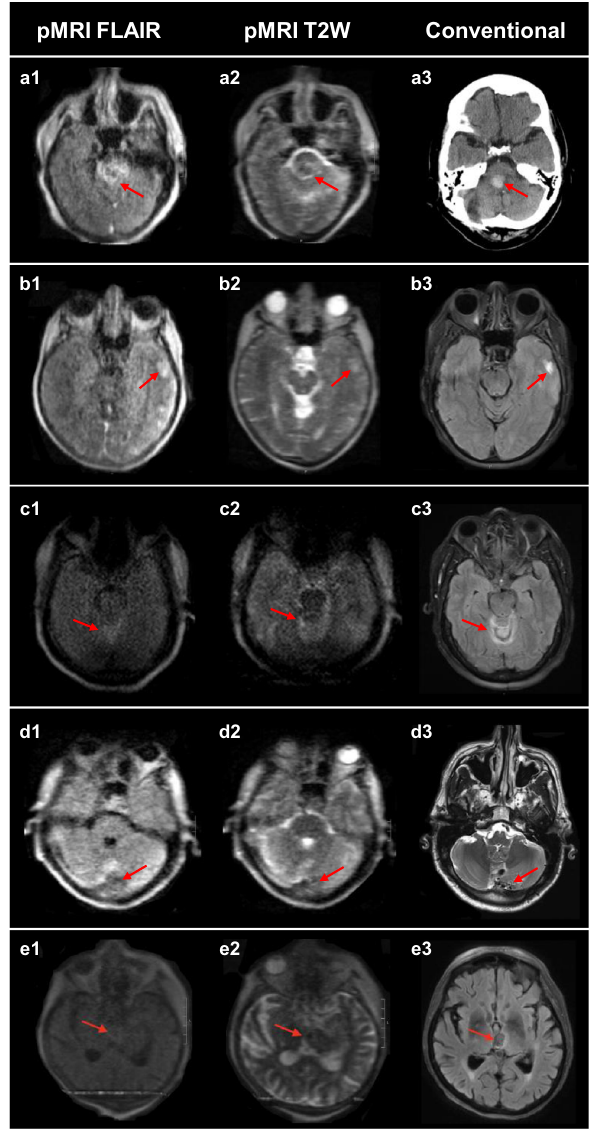
Fig. 3 False negative intracerebral hemorrhage cases. The fi rst and second columns are low- fi eld FLAIR and T2W images, respectively. The third column is a gold-standard clinical examination for comparison. (3T MRI: b3, d3, and e3; CT: a3). a Right cerebellar pontine intracerebral hemorrhage (ICH). Missed by all raters. b Left temporal ICH. Missed by all raters. c Bilateral cerebellar ICH. Missed by 2/3 raters. d Left cerebellum ICH. Missed by all raters. e Left thalamus ICH. Missed by all CI: [0.754 – 0.931], p = 1.66e-8) (Fig. 4b1). Bland – Altman plots showed a bias of − 3.74 cc (95% CI: − 6.62 to − 0.855] with limits of agreement from − 20.2 cc [95% CI: − 25.2 to − 15.2] to 12.7 cc [95% CI: 7.74 to 17.7] for pMRI T2W sequences (Fig. 4b2) and a bias of − 7.89 cc [95% CI: − 12.9 to − 2.85] with limits of agreement from − 38.0 cc [95% CI: − 46.6 to − 29.3] to 22.2 cc [95% CI: 13.5 – 30.9] for pMRI FLAIR sequences (Fig. 4b3). (Fig. 4c1). Bland – Altman plots showed a bias of 1.96 cc [95% CI: 0.609 – 3.32] with limits of agreement from − 5.76 cc [95% CI: